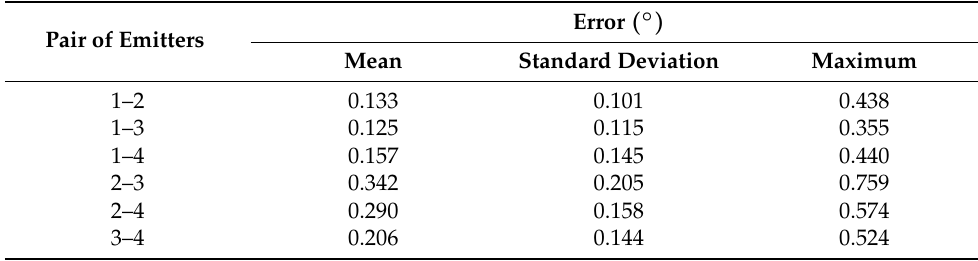
Table 1. Error values in the determination of the angles of rotation using all possible combinations of emitter